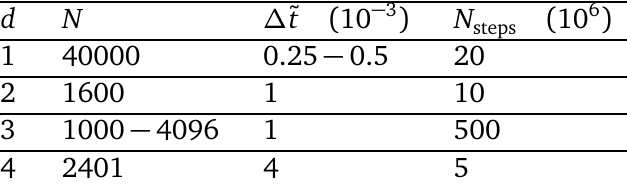
Table 1: Simulation parameters: The system size N , the reduced time step ∆ ˜ t , and the number of time steps simulated at each state point for all four dimensions consid- ered numerically in this work. For the LJ ( 300,6 ) potential, a smaller reduced time step ∆ ˜ t = 10 − 4 was used because of the potential steepness at small